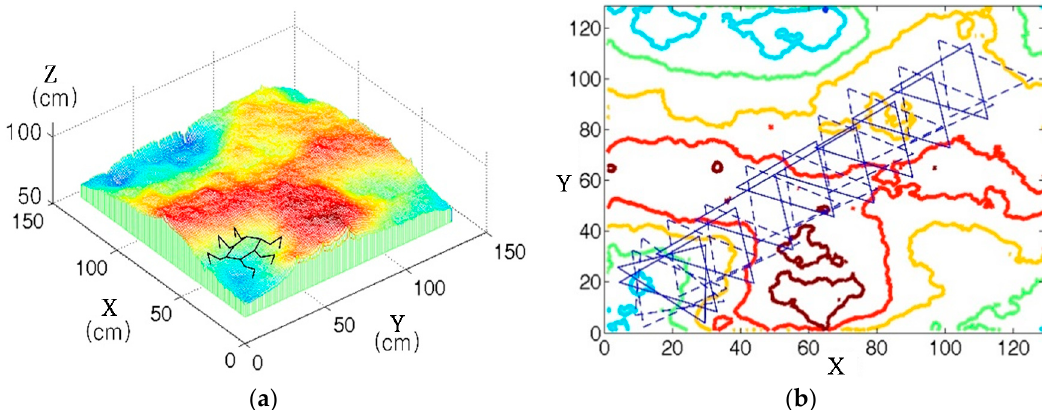
Figure 15. Posture control simulation in MATLAB: ( a ) Simulation environment of unstructured terrain walking, and ( b ) projection on the XY plane of MP.